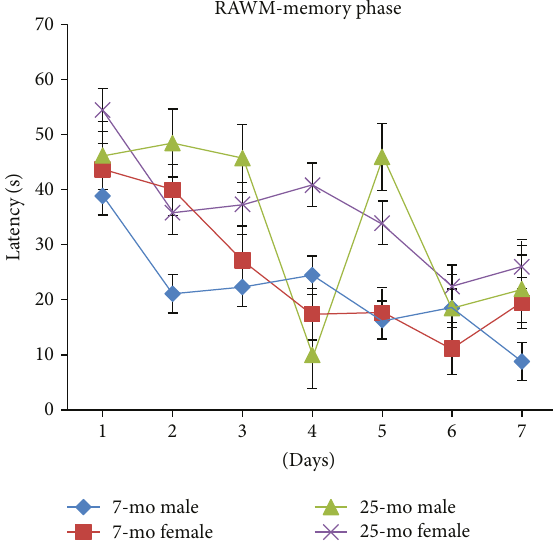
Figure 10: Latencies of 7- and 25-month-old C57BL/6 mice in memory phase of RAWM (s, mean ± SEM). ∗∗ P < 0 01 .